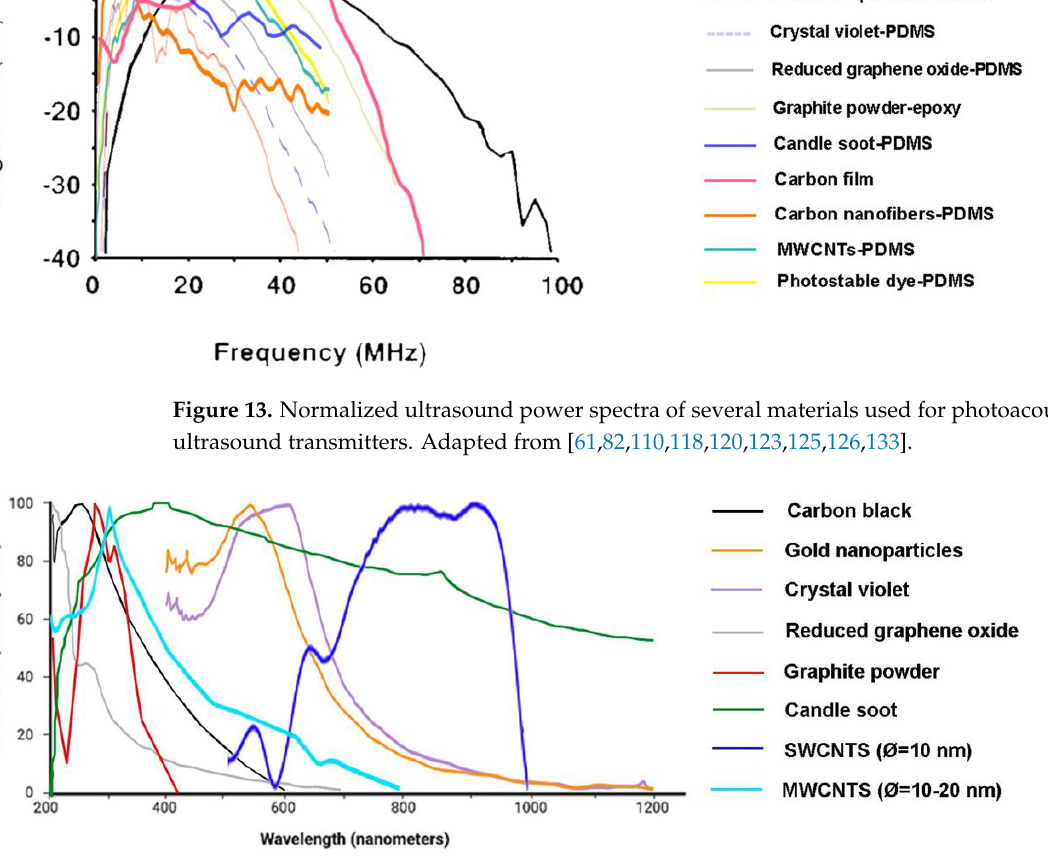
Figure 14. Curves showing the wavelength at which maximum optical absorption occurs for each material. Adapted from [61,134 – 139].